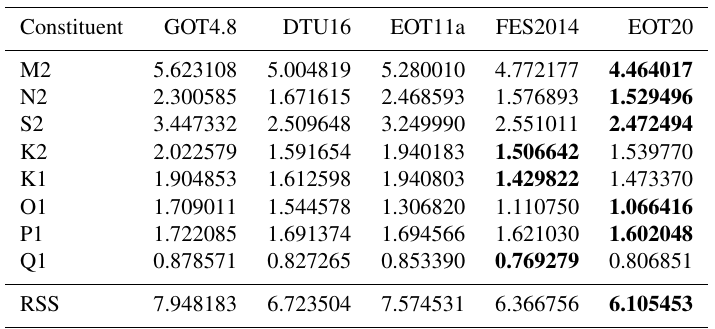
Table 3. The rms, in cm, of the tide gauge analysis of 1226 tide gauges for the EOT20 model as well as several other global ocean tide models. The values marked in bold indicate the model with the smallest rms for each row.